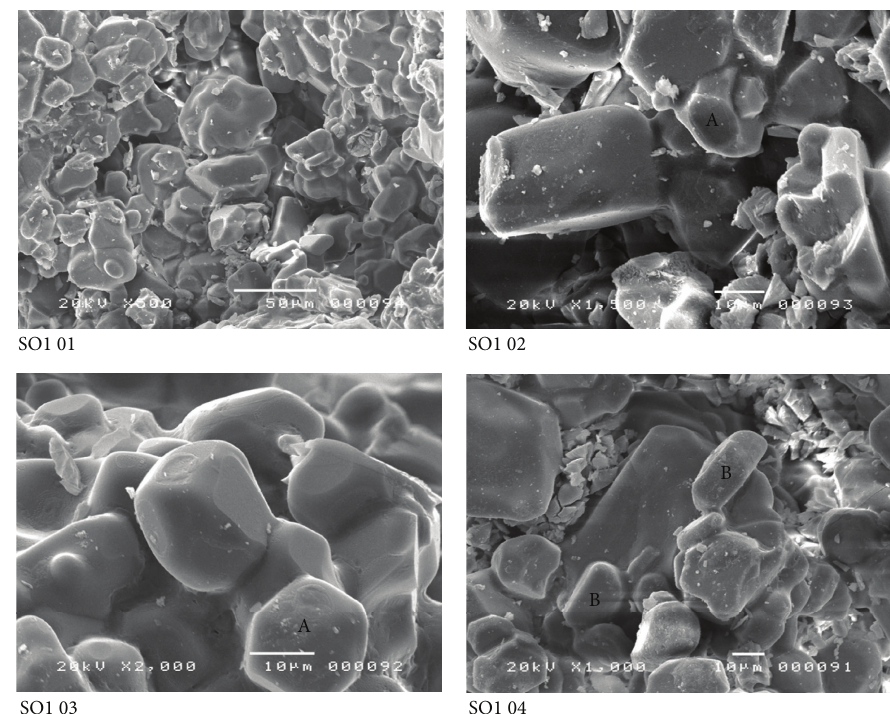
Figure 3: SEM observations of the SO1 sample: (A: alite and B: belite).